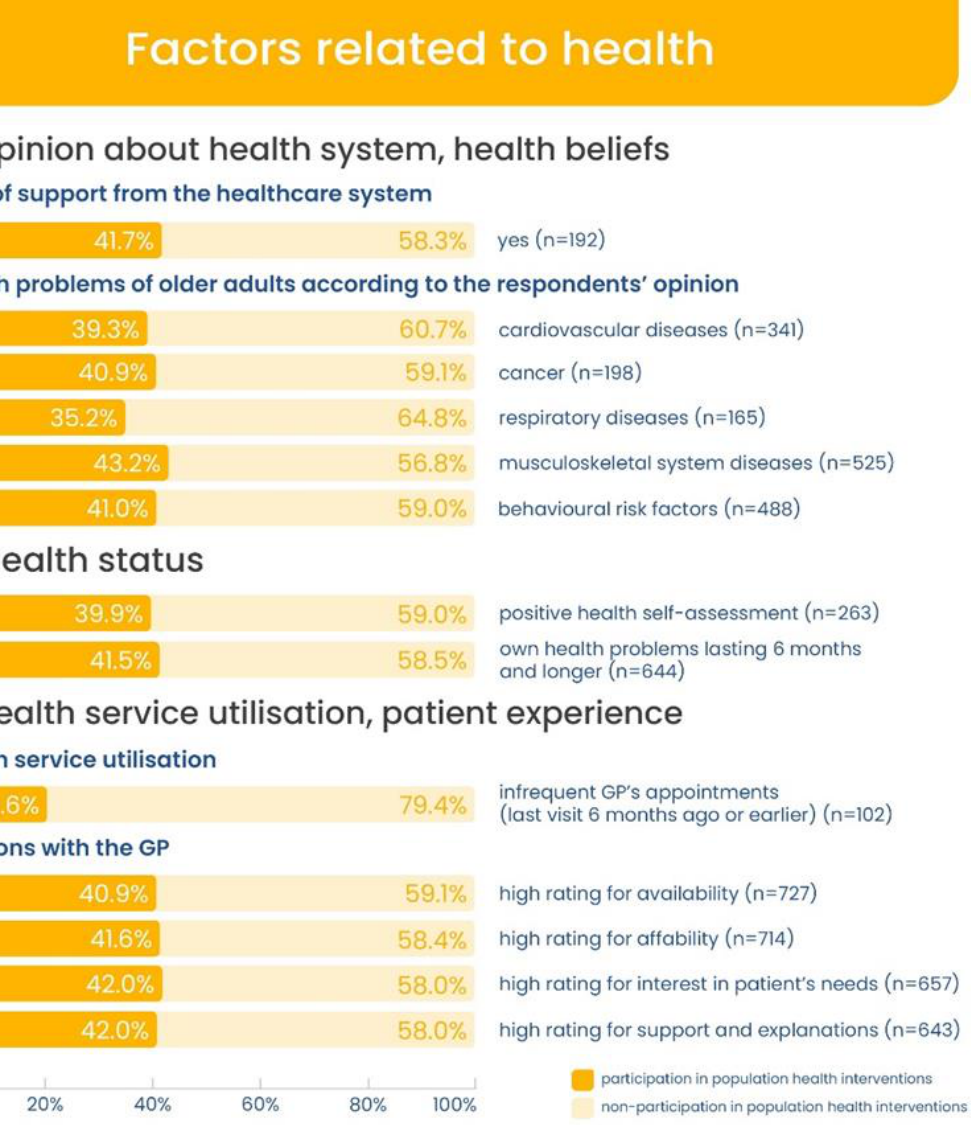
Figure 3. Participation in health programmes in subgroups (participating and non-participating) by health-related variables (in percentage).